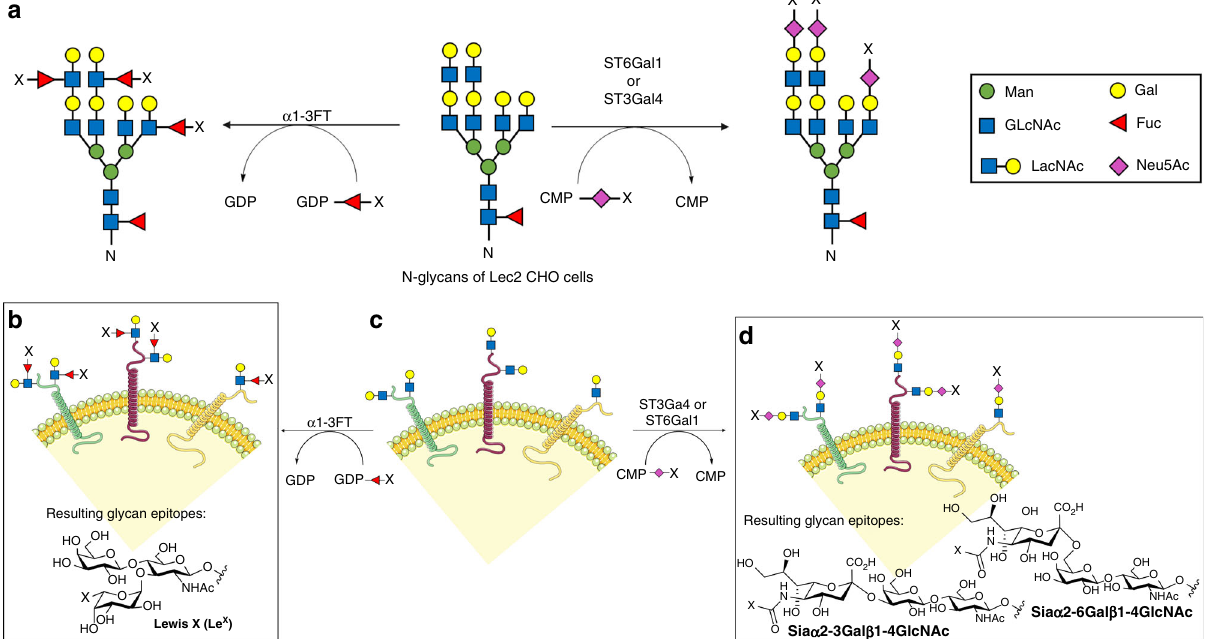
Fig. 1 The work fl ow for constructing cell-based glycan arrays. a Distinct glycan epitopes are installed onto N-glycans of Lec2 CHO cells via sialyltransferase-mediated cell-surface in situ sialylation using the CMP-Neu5Ac donor (or its analogs) or fucosyltransferase-mediated cell-surface in situ fucosylation using the GDP-Fuc donor (or its analogs). b Cell-based glycan arrays displaying Le X or its derivatives. c N-glycans of Lec2 CHO cells. d Cell- based glycan arrays displaying α 2-3- or α 2-6-linked sialosides, or their derivatives. X represents unnatural substituents introduced at fucose C-5 or NeuNAc acetyl